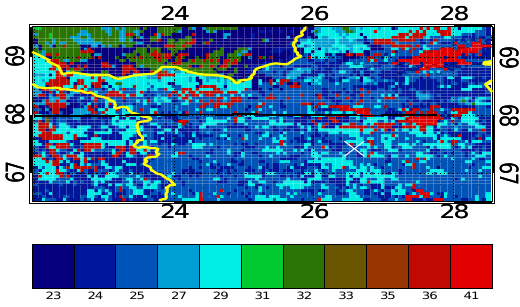
Figure 9. Underlying surface-type classification map [48] used to identify prevalent vegetation and land use types within transect x for flights B796b, B797 and B804, within the coordinates of 67.5°– 68.5° N and 22.1°–27.9° E. The white cross is used as a reference point to identify the town of Sodankyla in Finland, and the yellow markings signify the borders between Sweden ( left ), Norway ( top ) and Finland ( right ). The black line represents the specific flight path for B796b and the colour coded legend is identified in Table 2.